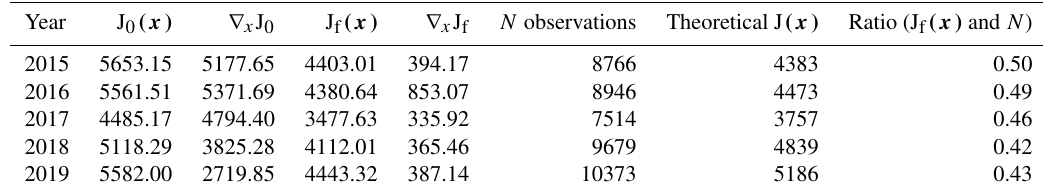
Table 2. Convergence diagnostics of the inversion system using OCO-2 satellite